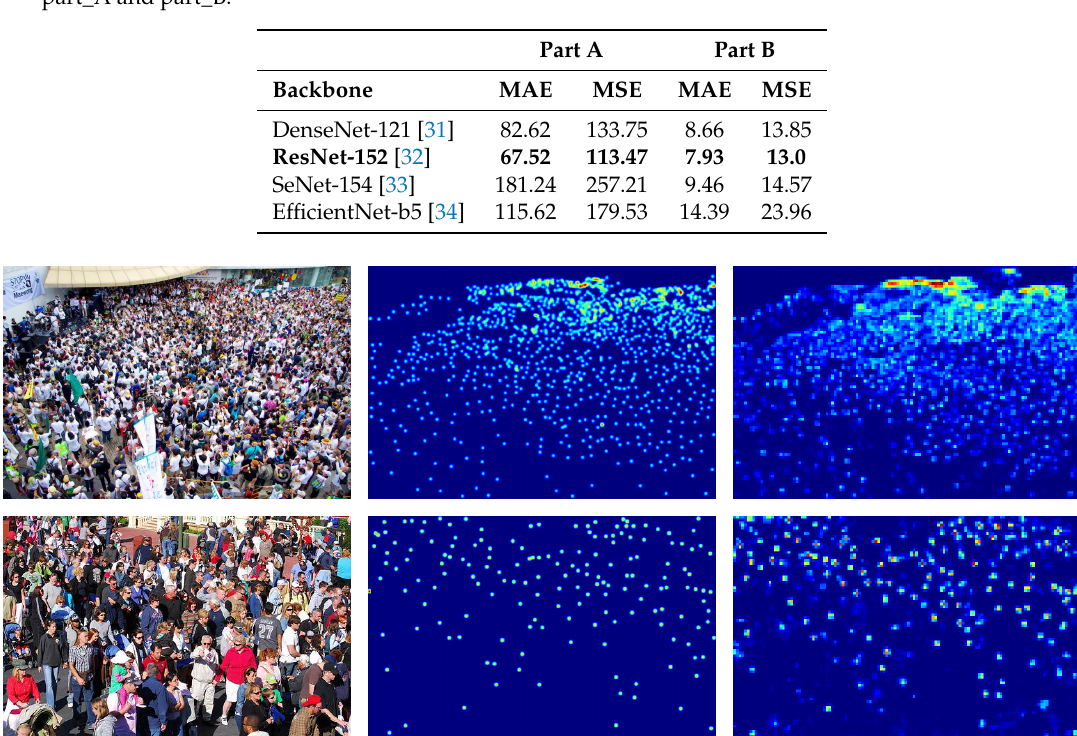
Figure 6. UCF_CC_50 density map estimation examples, ( Left ) the crowd image, ( Center ) ground-truth density map, ( Right ) estimated density map. Table 3. Proposed MH-MetroNet architecture performance with different backbones on ShanghaiTech part_A and part_B.